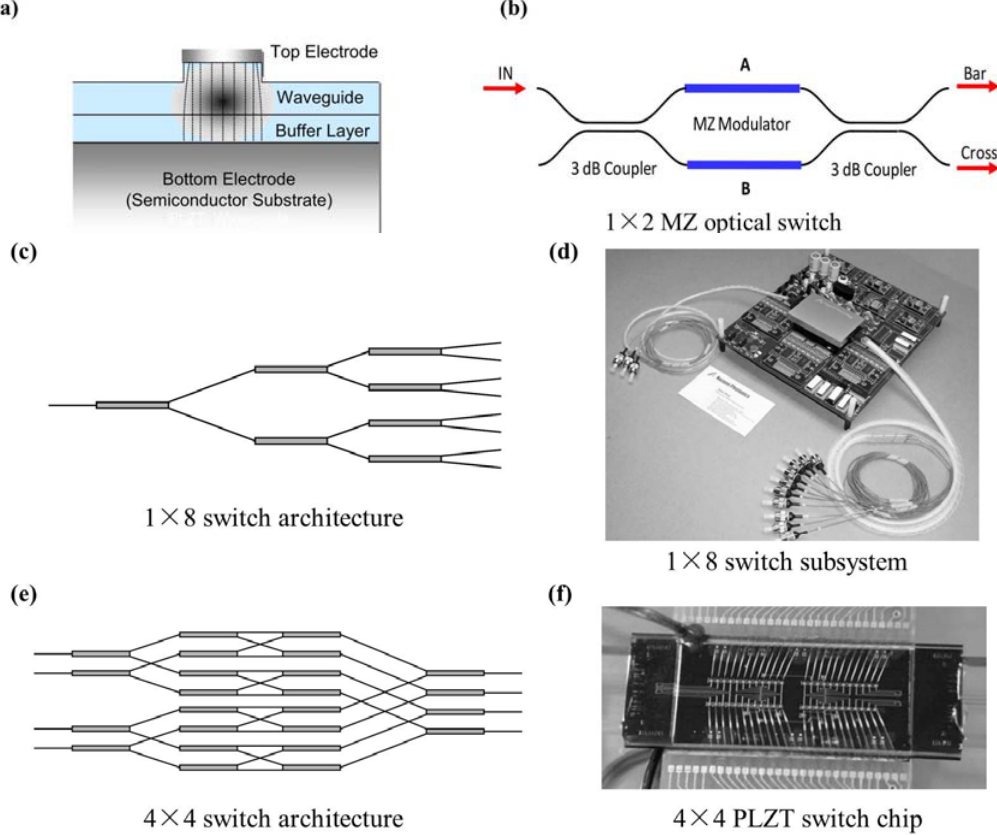
Figure 25. ( a ) Sandwiched electrode geometry for electrooptical switches; ( b ) the 1 × 2 MZ optical switch; ( c ) the designed 1 × 8 switch architecture; ( d ) a practical 1 × 8